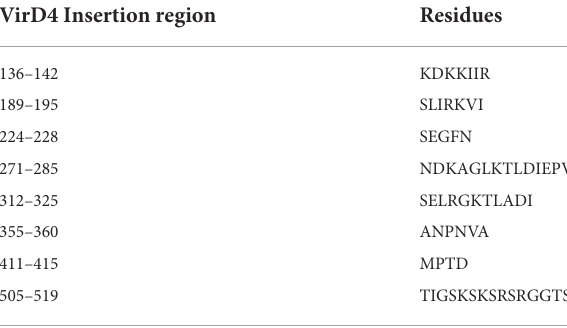
TABLE 1 The position of the insertion region and the number of residues in each